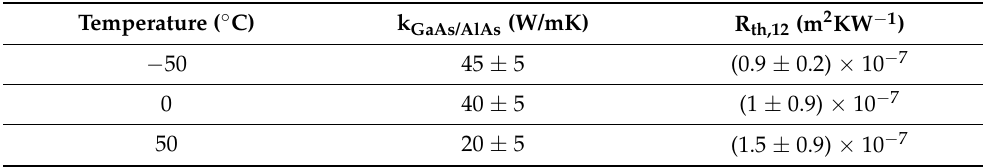
Table 4. In-plane thermal transport parameters of AlAs/GaAs superlattice obtained from fits to the PTR data in Figure 5 for different temperatures.